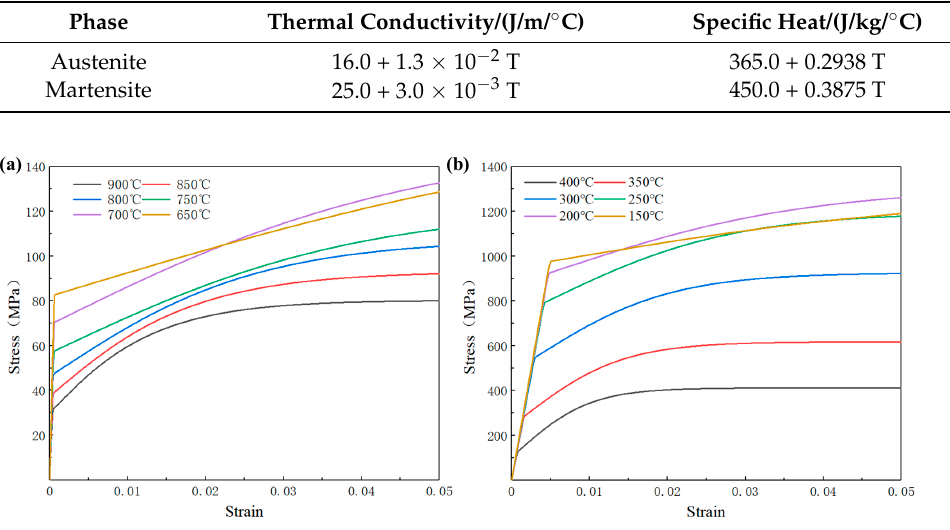
Figure 4. True stress-strain curves of 9310 steel at different temperatures: ( a ) austenite; ( b ) marten- site.